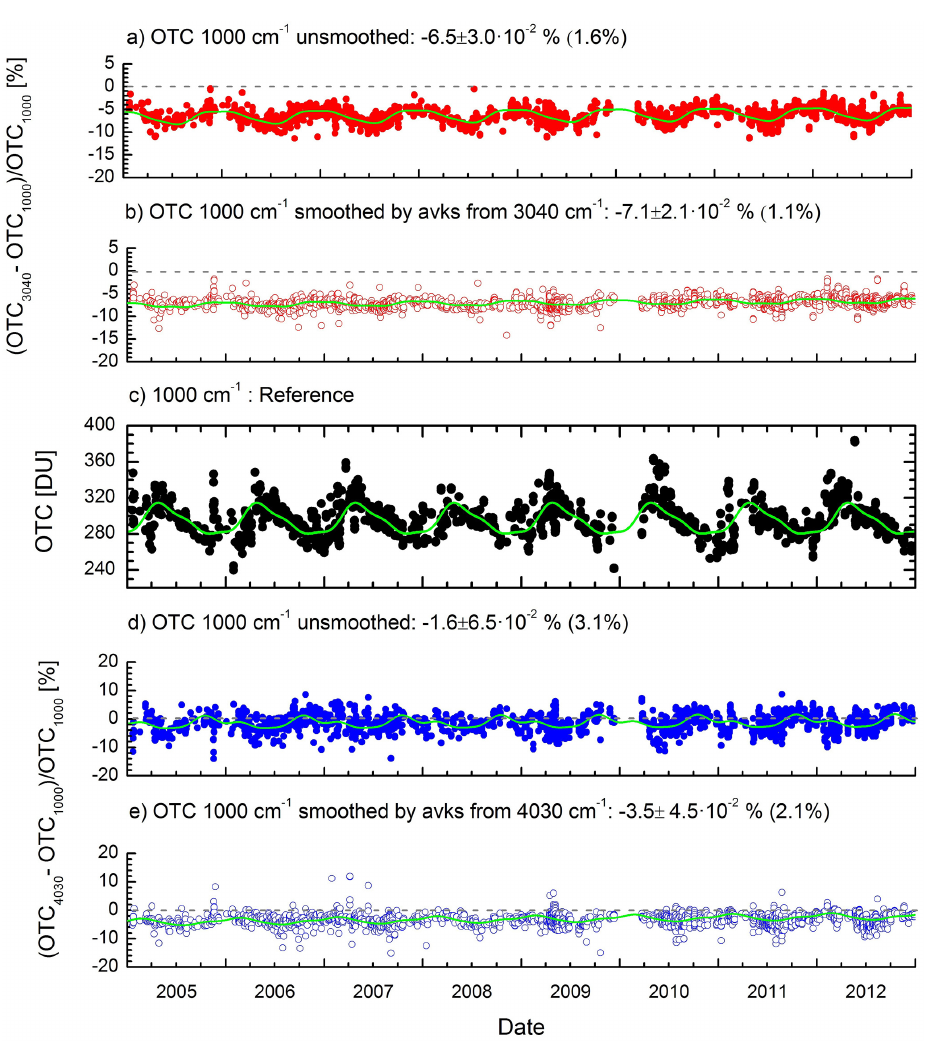
Figure 5. Consistency of OTC time series at Izaña between 2005 and 2012 using different spectral regions: (a) relative difference [%] between the 3040 and 1000cm − 1 OTC. (b) Same as (a) , but after smoothing the 1000cm − 1 OTC data with the 3040cm − 1 averaging kernels (see Eq. 3). (c) Time series of the 1000cm − 1 OTC. (d) and (e) same as (a) and (b) , respectively, but for the OTC retrievals in the 4030cm − 1 region. The mean, the standard error of the mean (SEM) and the standard deviation (1 σ , in brackets) of the relative differences are shown in the legend for each spectral region. The green solid line is the multi-annual evolution fitted according to Eq. (C1) in Appendix C.